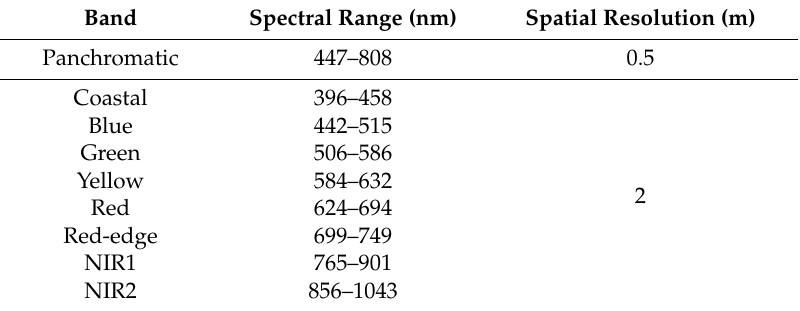
Table 1. Spectral band information of WorldView-2